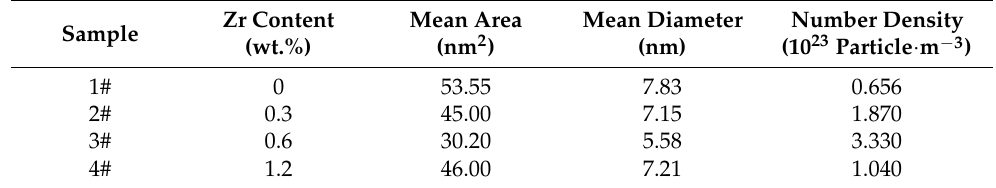
Table 2. Statistical results of nano-precipitate distribution in FeCrAl ODS steels with different Zr contents.